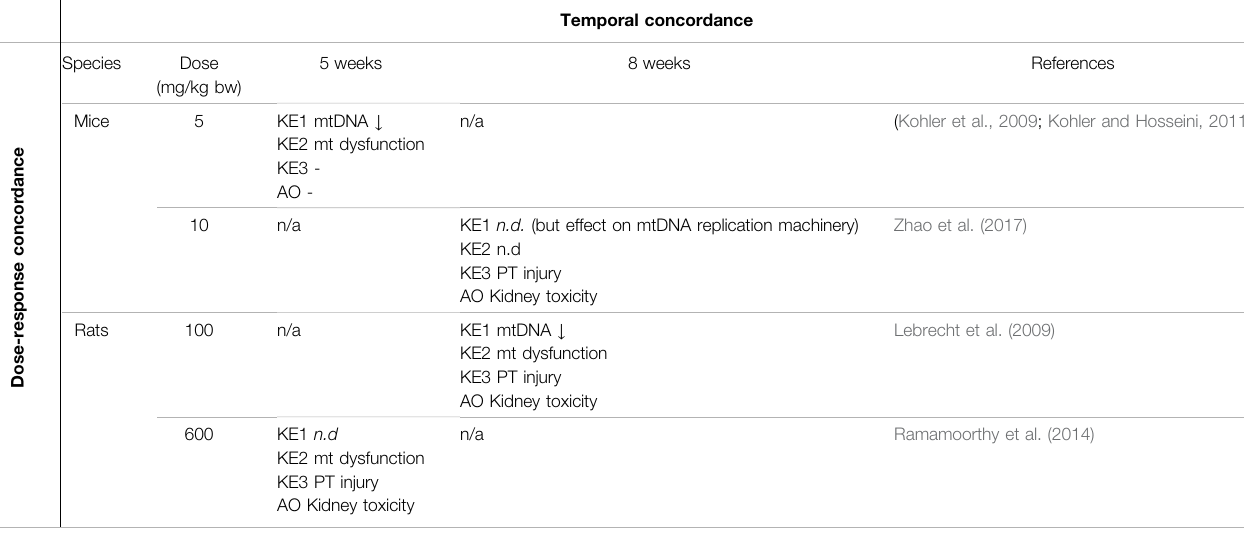
TABLE 2 | Dose-Time Concordance of KEs based on rodent studies with tenofovir disoproxil fumarate (TDF) as a speci fi c stressor for the adverse outcome pathway of inhibition of mitochondrial DNA polymerase γ leading to kidney toxicity (n.d. = not determined; n/a = no data available).